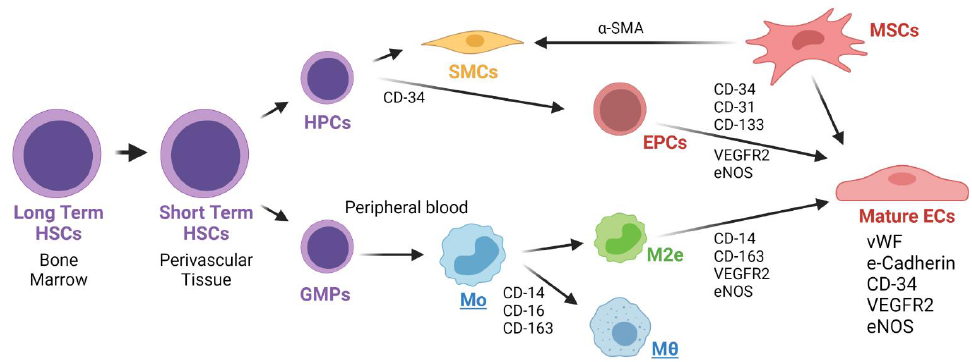
Figure 6. Different proposed origins for Endothelial Progenitor Cells (EPCs). From hematopoietic stem cells (HSC) to hematopoietic progenitor cells (HPCs) that can then differentiate to SMCs and EPCs, HSCs can also differentiate towards granulocyte monocyte progenitors (GMPs), in which monocytes differentiate to monocytes (Mo) and then to an M2e macrophage expressing endothelial markers. Mature ECs can also be derived from mesenchymal stem cells (MSCs). (Created with BioRender.com, accessed on 3 February 2022).